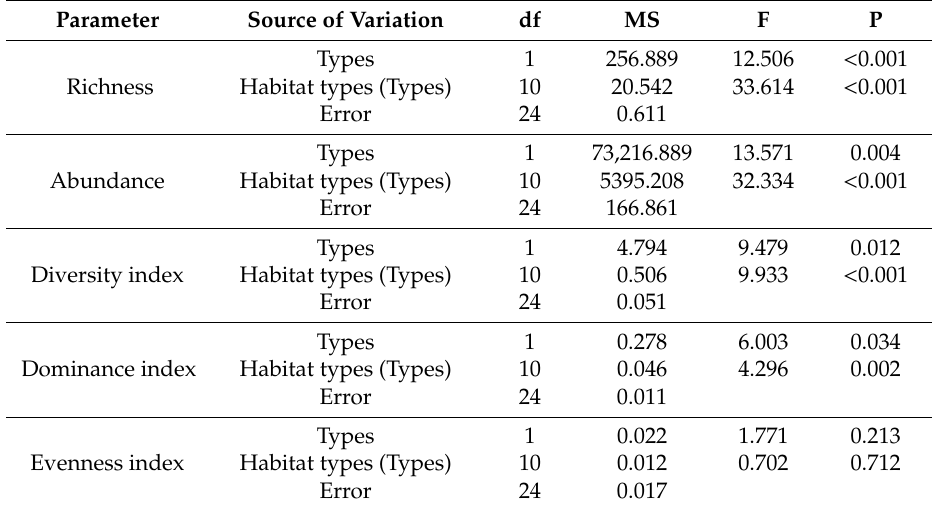
Table 2. ANOVA showing di ff erences in carabid richness and abundance along with types (former or current habitat types) and among habitat types within